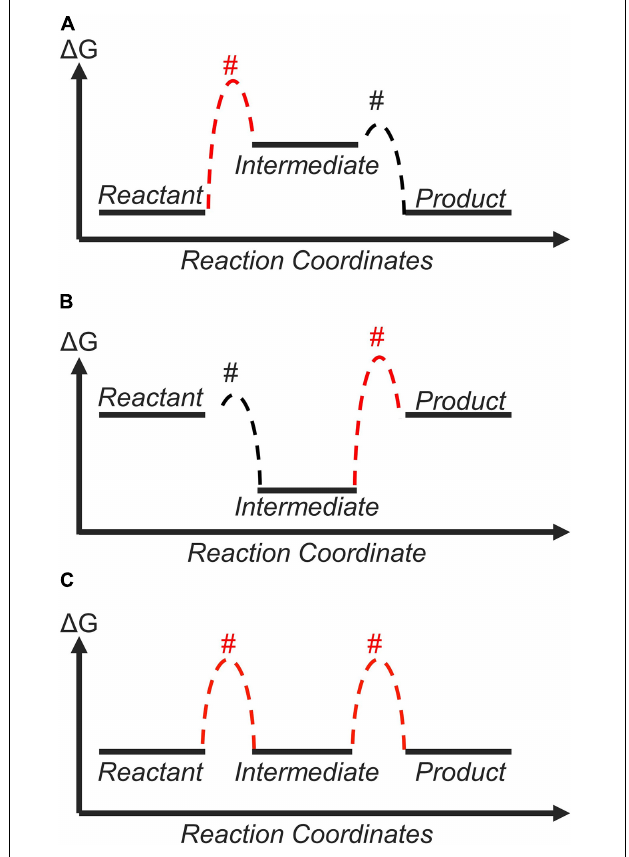
FIGURE 5 | The free-energy landscape of a two-step electrocatalytic process in equilibrium. The heights of transition states indicated by # were drawn assuming a constant BEP coefficient: (A) weak-binding catalyst; (B) strong-binding catalyst; (C) thermoneutral catalyst. The highest transition state, shown in red, occurs at the reaction step with the least favorable thermodynamics. Therefore, the thermodynamically ideal catalyst (C) should also be the kinetically ideal